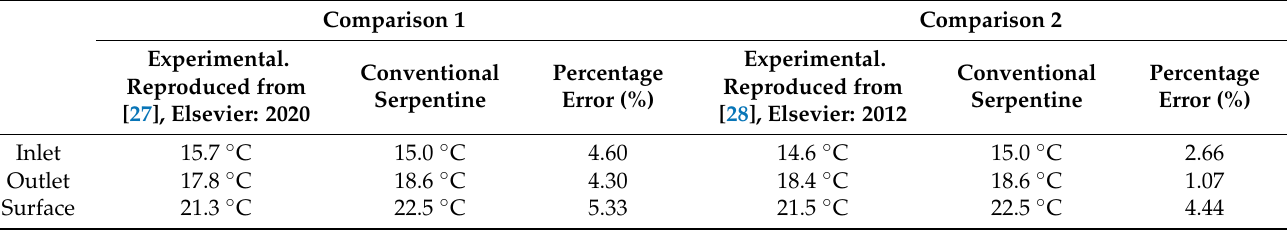
Table 5. Comparison with experimental results from other literatures.